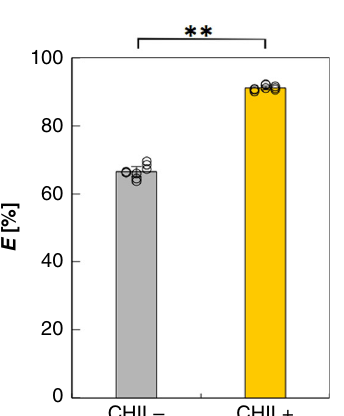
Fig. 6 Effects of CHIL on in vivo speci fi city of CHS. E values of CHS- catalyzed reactions during the production of CLC from p -coumaric acid in E. coli cells harboring pET15b-Gm4CL-3-GmCHS-1 (CHIL – ) or pET15b- Gm4CL-3-GmCHS-1-GmCHIL (CHIL + ) are shown. Data are presented as the average of three independent determinations of three biological replicates (±standard error). ** P < 0.01 (Student ’ s t -test). The underlying data are provided in the Source Data fi